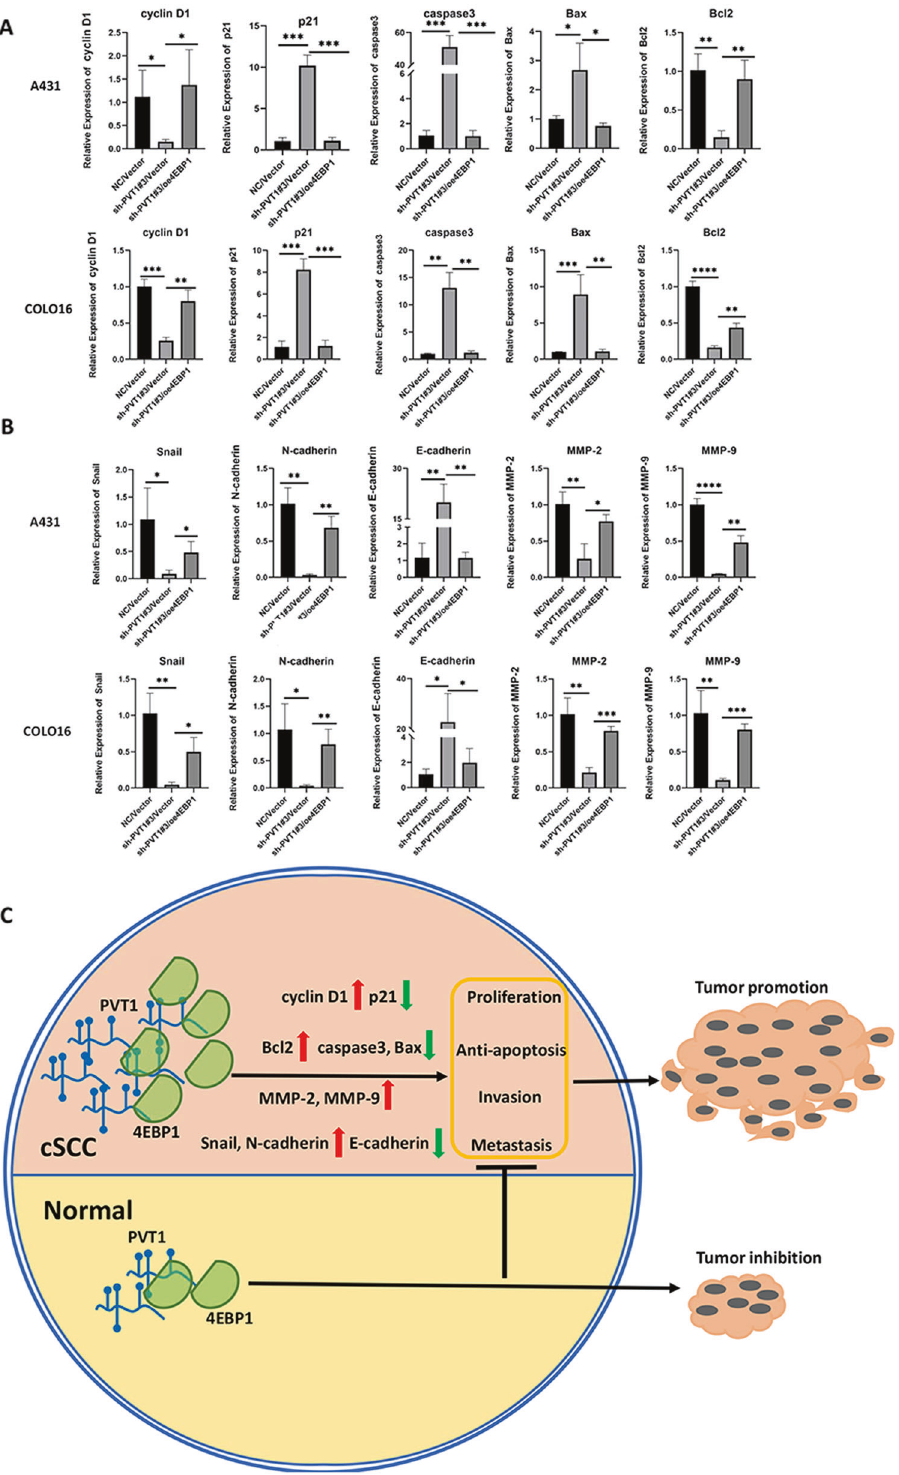
Fig. 8 The mechanism of lncRNA PVT1/4EBP1 promotion of cSCC progression and tumorigenesis. A Expression of the proliferation (cyclin D1, p21) and apoptosis (caspase3, Bax, Bcl2) indexes measured by RT-qPCR in stable PVT1-knockdown A431 and COLO16 cells co-transfected with 4EBP1-overexpression constructs. B Expression of the metastasis (Snail, N-cadherin, E-cadherin) and invasion (MMP-2, MMP-9) indexes measured by RT-qPCR in stable PVT1-knockdown A431 and COLO16 cells co-transfected with 4EBP1-overexpression constructs. C Schematic model illustrates the mechanism by which PVT1 interacts with 4EBP1 to promote tumorigenesis of cSCC. * P < 0.05, ** P < 0.01, *** P <